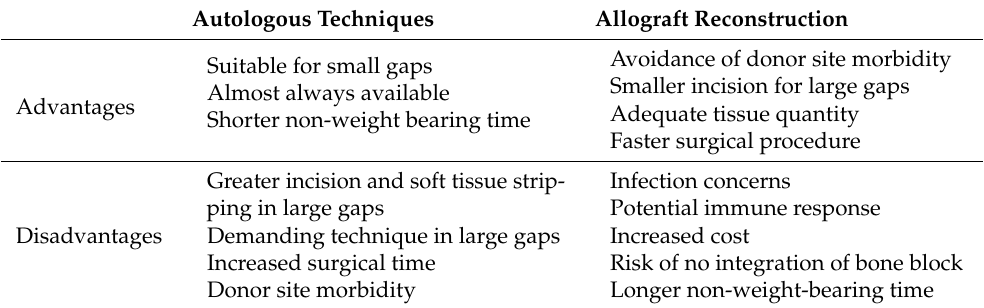
Table 4. Summary of advantages and disadvantages of autologous vs. allograft